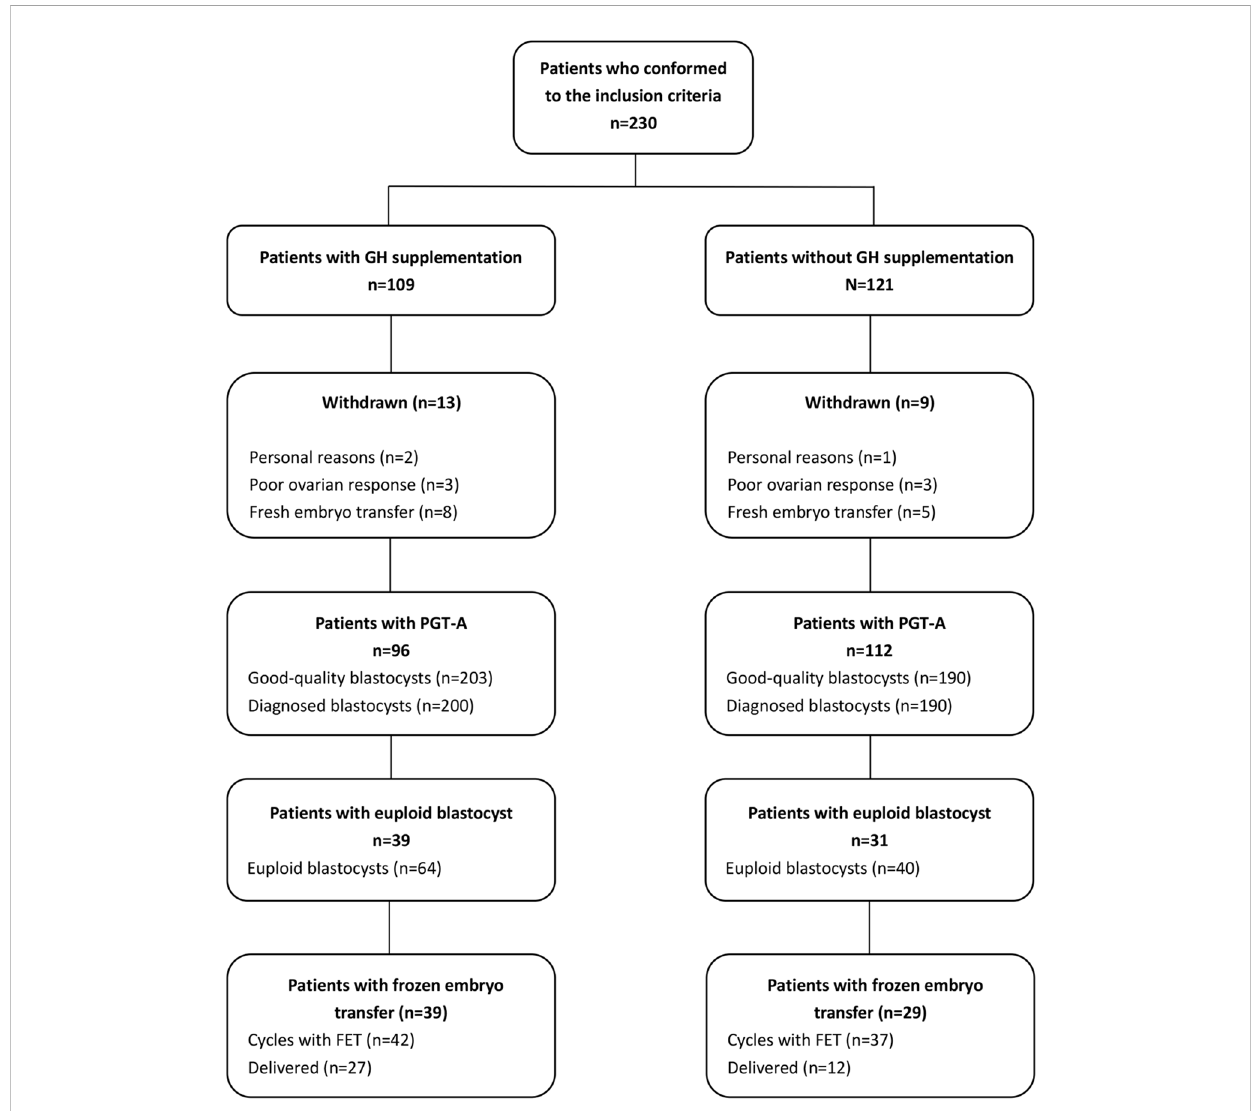
FIGURE 1 Diagrammatic representation showing the processes of patient inclusion and exclusion in the